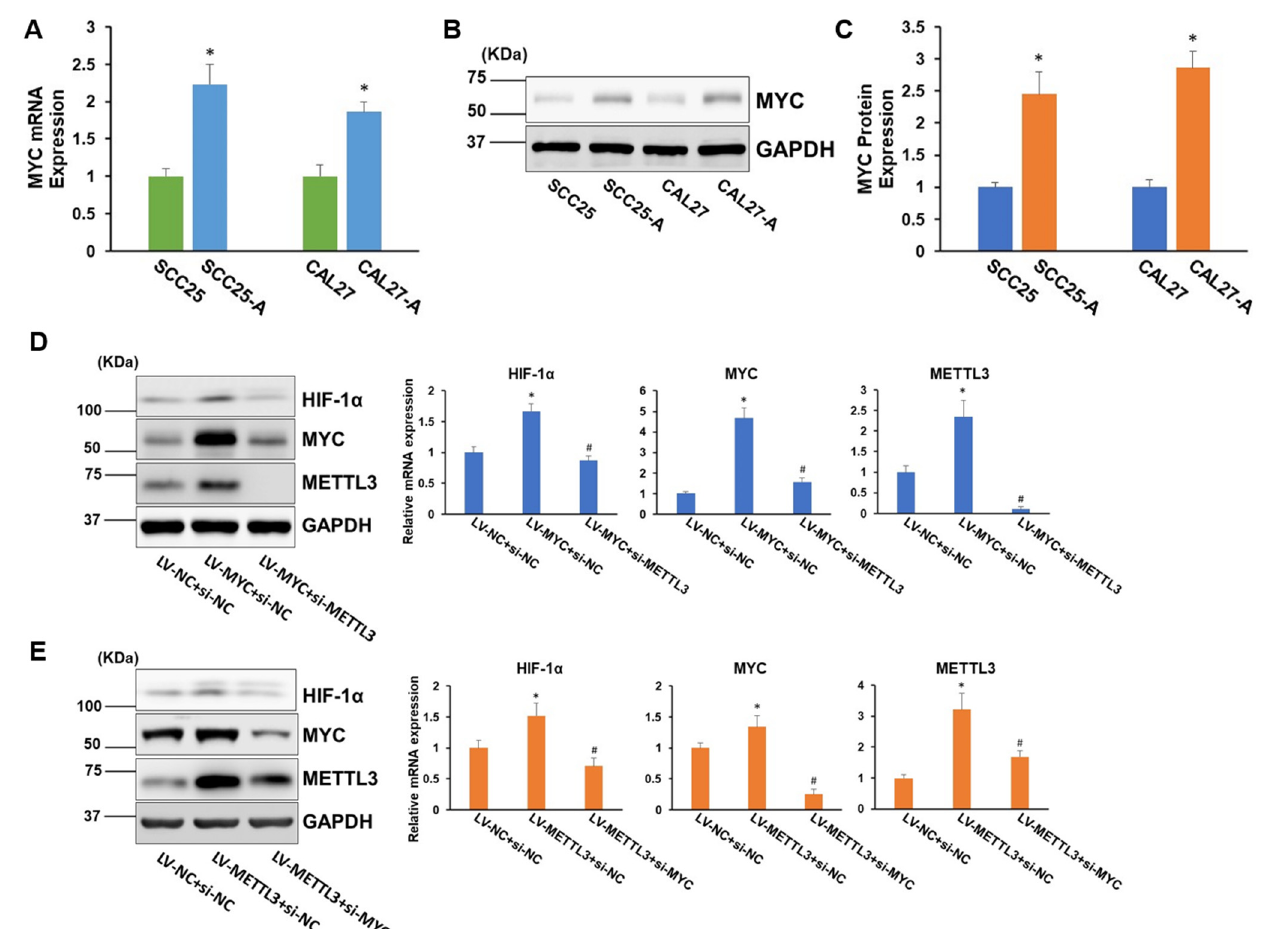
Figure 4. A positive autoregulation loop is formed between METTL3, MYC, and HIF-1 α . ( A ) The mRNA levels of MYC in CAL27, SCC25, CAL27-A, and SCC25-A were measured. ( B , C ) The MYC protein levels in CAL27, SCC25, CAL27-A, and SCC25-A cells were tested ( B ) and quantified by Image J ( C ). ( D ) CAL-27 cells were transduced with lentiviruses carrying MYC cDNA (LV-MYC) or NC (LV-NC). Then, cells were transfected with siRNA targeting METTL3 (si-METTL3) or NC (si-NC). The protein and mRNA levels of HIF-1 α , MYC, and METTL3 were measured. ( E ) CAL-27 cells were transduced with LV-METTL3 or LV-NC. Then, cells were transfected with siRNA targeting MYC (si-MYC) or NC (si-NC). The mRNA and protein levels of HIF-1 α , MYC, and METTL3 were measured. * p < 0.05 compared to the control group. # p < 0.05 LV-MYC + si-METTL3 compared to LV-MYC + si-NC or LV-METTL3 + si-MYC compared to LV-METTL3 + si-NC.